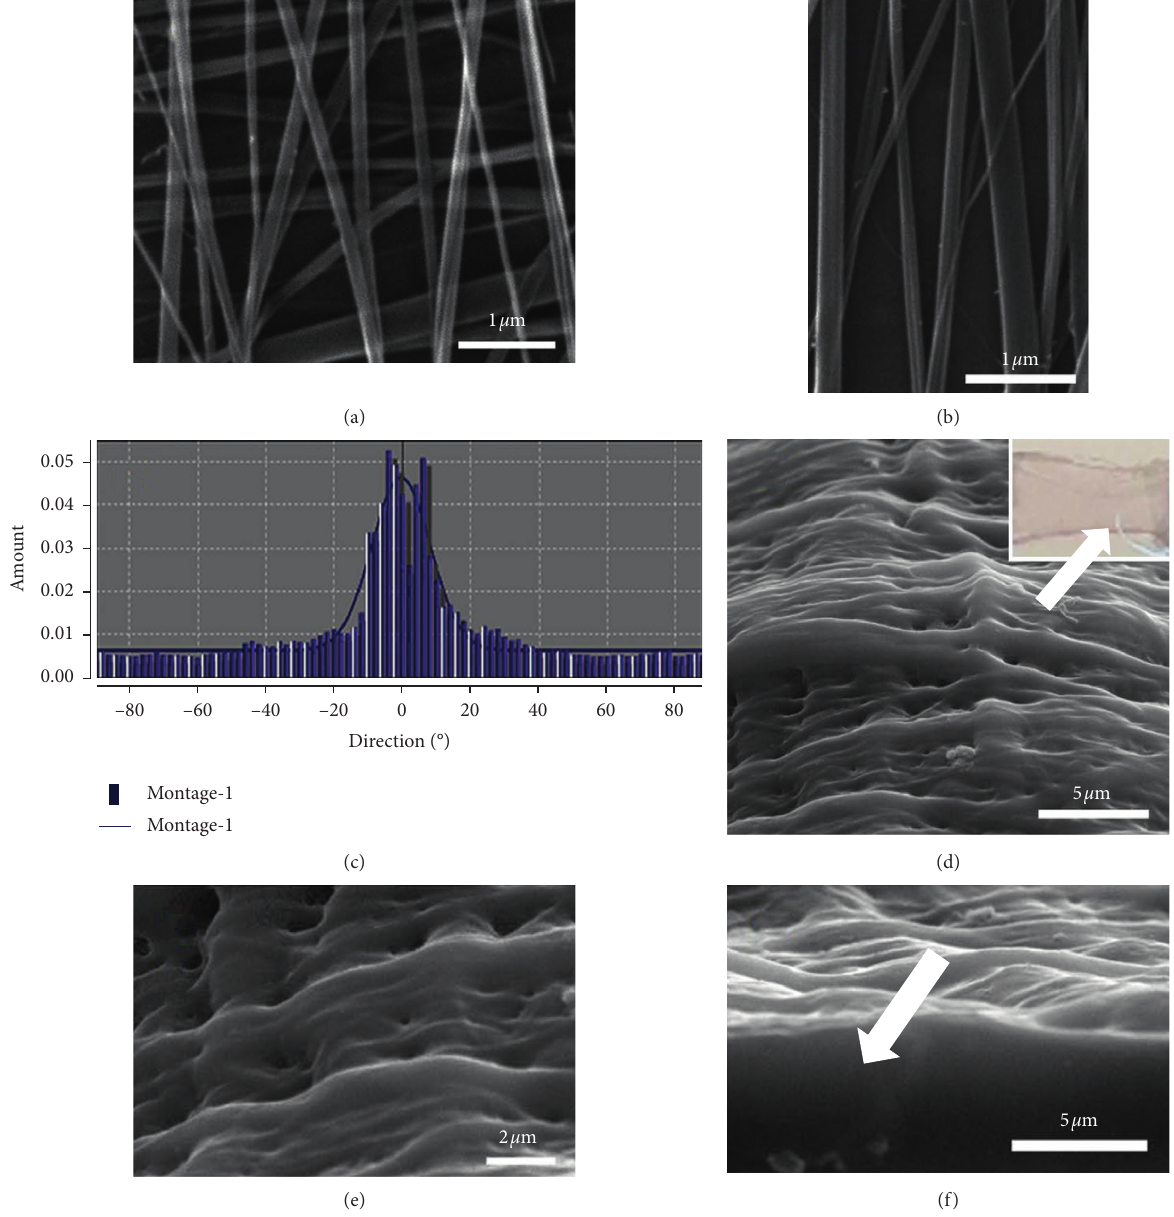
Figure 3: Scanning electron micrographs of electrospun collagen fibers before and after cross-linking. (a) The orientation of the aligned fibers in each layer compared to the fibers in adjacent lamella. (b) The morphology of the parallel arrangement of collagen fibers in non- cross-linked scaffold. (c) Fiber orientation histogram. (d and e) Cross-linked multilayered scaffolds with aligned uniaxially oriented electrospun fibers in each layer. Black arrow shows the transparency of the scaffold. (f) Freeze fracture of cross-linked multilayered collagen fibers (white